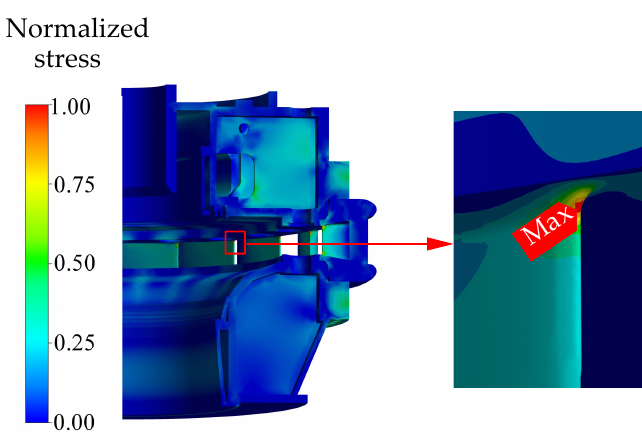
Figure 17. The stress distribution of the large stationary structures. Since the connecting bolts bear the large pressure from the flow channel and tighten the stationary structures of the unit together, high stresses during the turbine load rejection appear also on the head-cover bolts, bottom ring bolts, the flange beams, and the bolt flanges (Figure 17). The bolt couples are evenly distributed along the circumference in the large stationary structures so that the stress distribution in each bolt couple shows a similar distribution (Figure 18).